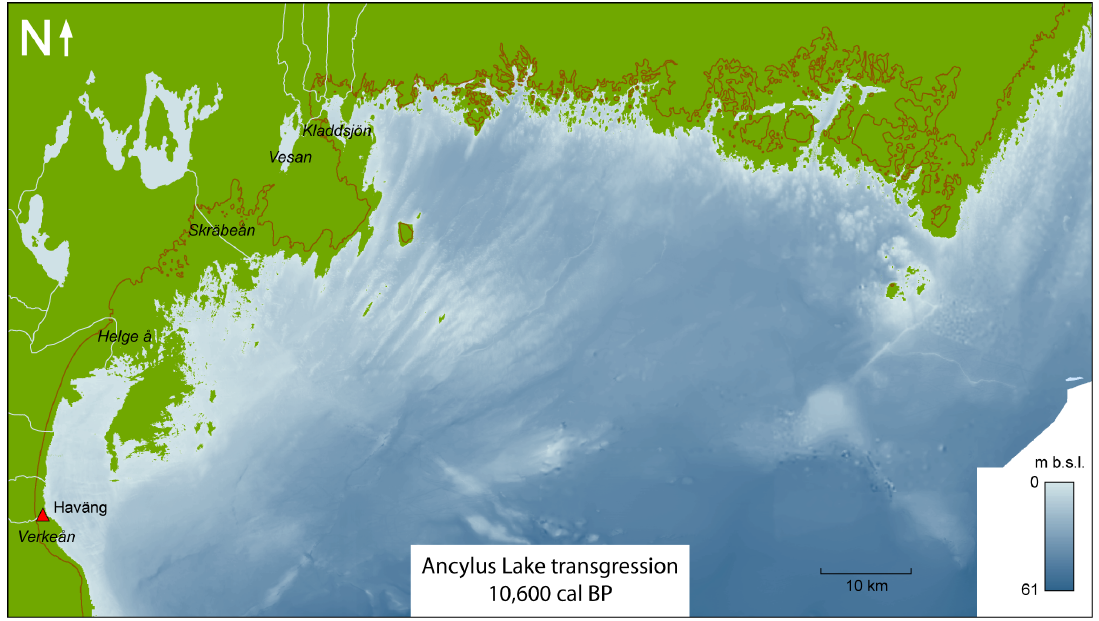
Figure 7. Palaeo-shoreline reconstruction of the study area during the Ancylus Lake transgression. The red line represents the present coastline. The red triangle represents the archaeological site discussed in the text. Light blue lines represent rivers discussed in the